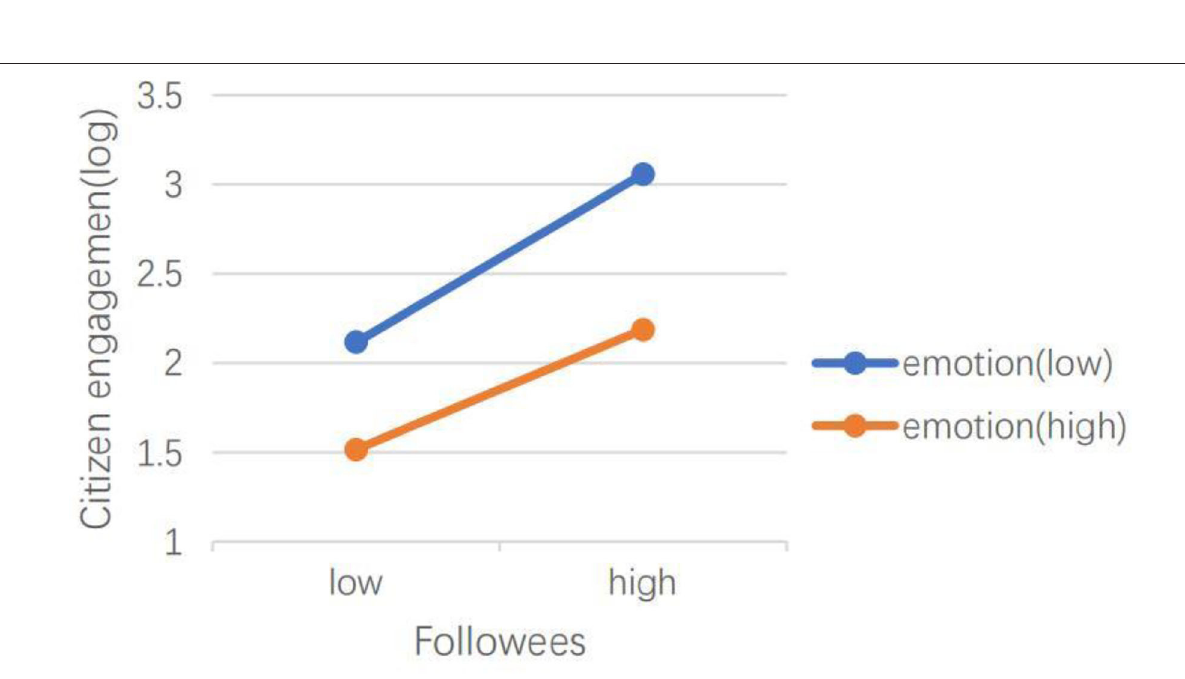
that in the Case Drop Stage , the emotional valence moderated the relationship between the number of followers (IRR = 1.00, P < 0.05), the number of followees (IRR = 1.00, P < 0.001), media richness (IRR = 1.06, P < 0.05), and CEGSM. As shown in